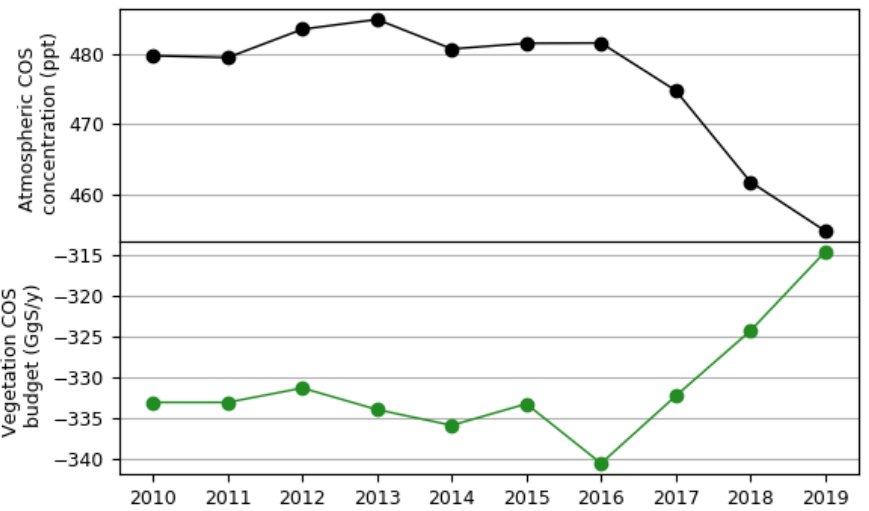
Figure 3. Evolution between 2010 and 2019 of NH mean annual atmospheric COS concentration and NH mean annual plant COS uptake computed with a monthly variable atmospheric COS concentration. Adapted from [17,27]. Note that land uptake is expressed negatively, following the atmospheric convention.